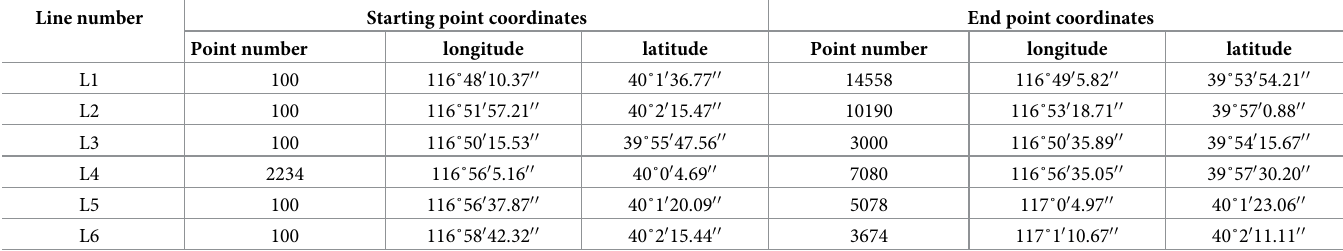
Table 1. Coordinates of shallow seismic exploration